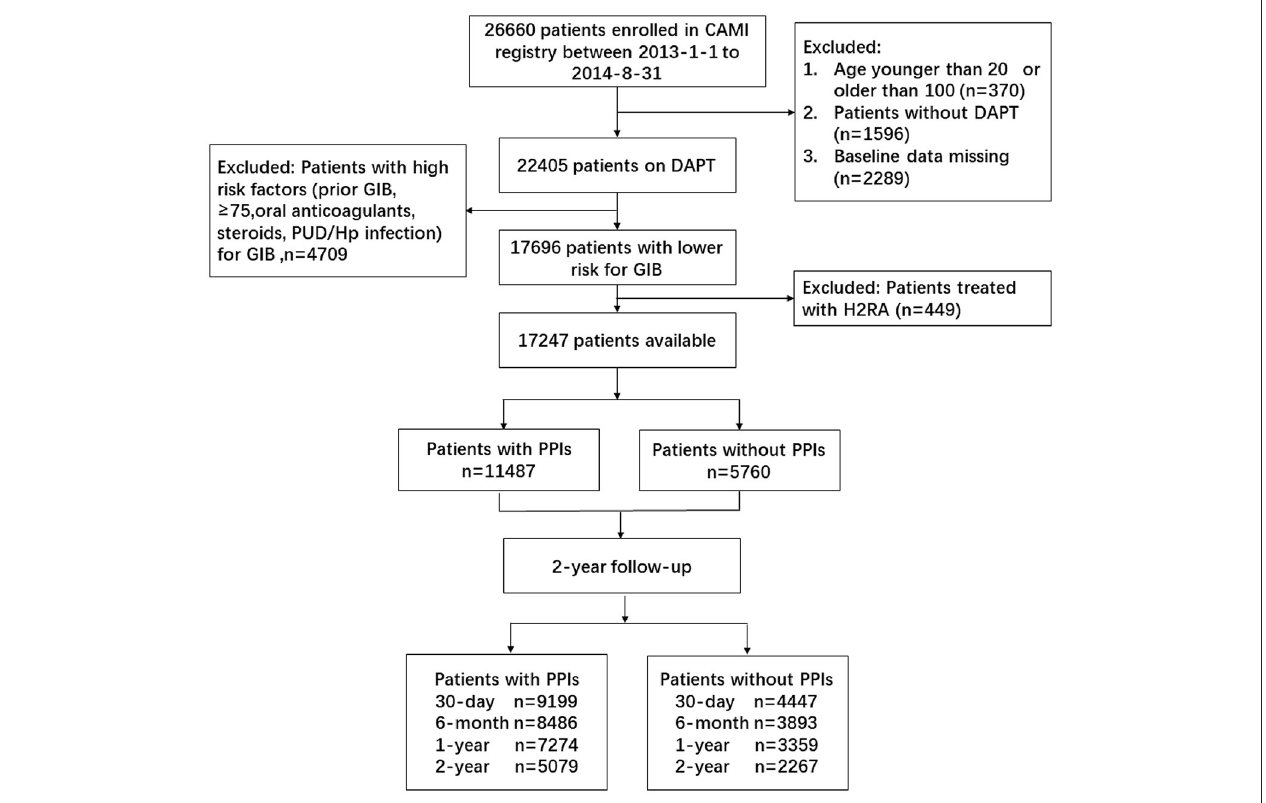
FIGURE 1 | Patient flowchart for the study cohort. CAMI, China Acute Myocardial Infarction; DAPT, dual antiplatelet therapy; GIB, gastrointestinal bleeding; PUD, peptic ulcer disease; PPIs, proton pump inhibitors.